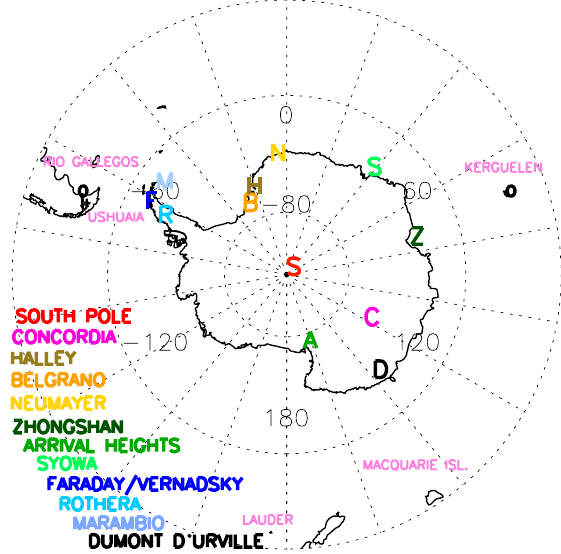
Fig. 2. The ground-based stations in the Antarctic and southern mid-latitudes considered in the ozone loss analyses. The mid- latitude stations are shown in light pink colour. The positions of Antarctic stations are marked by the first letter of their names in respective